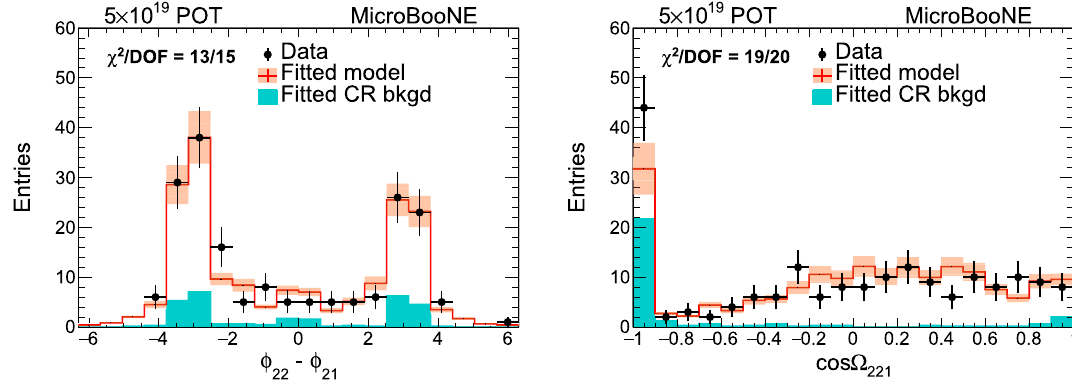
Fig. 21 Multiplicity = 2 φ 2 − φ 1 distribution (left); cos (cid:18) 21 distribution (right) from neutrino-enriched sample for data and GENIE default MC